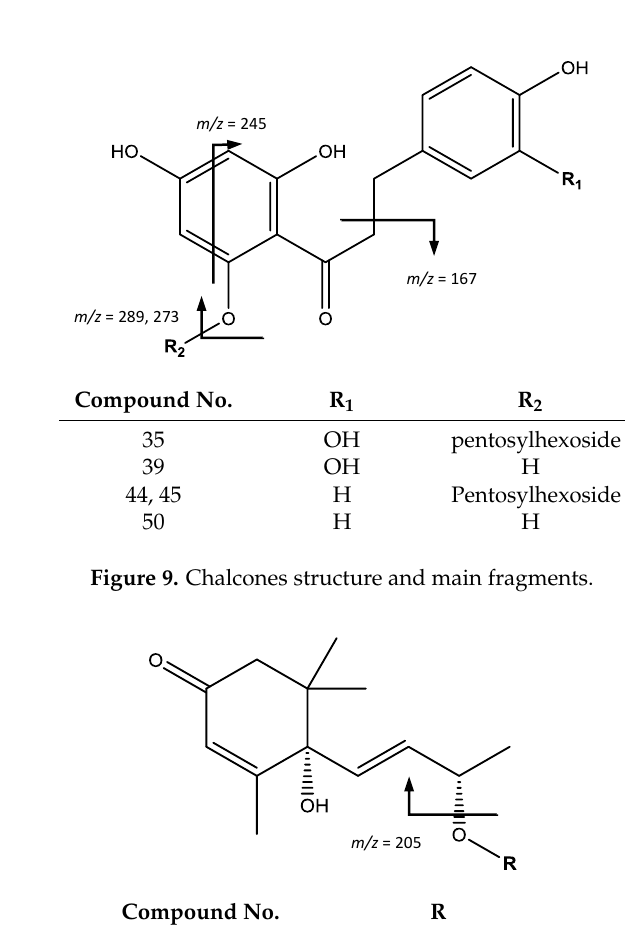
Figure 10. Vomifoliol-pentosylhexoside structure and main fragments.